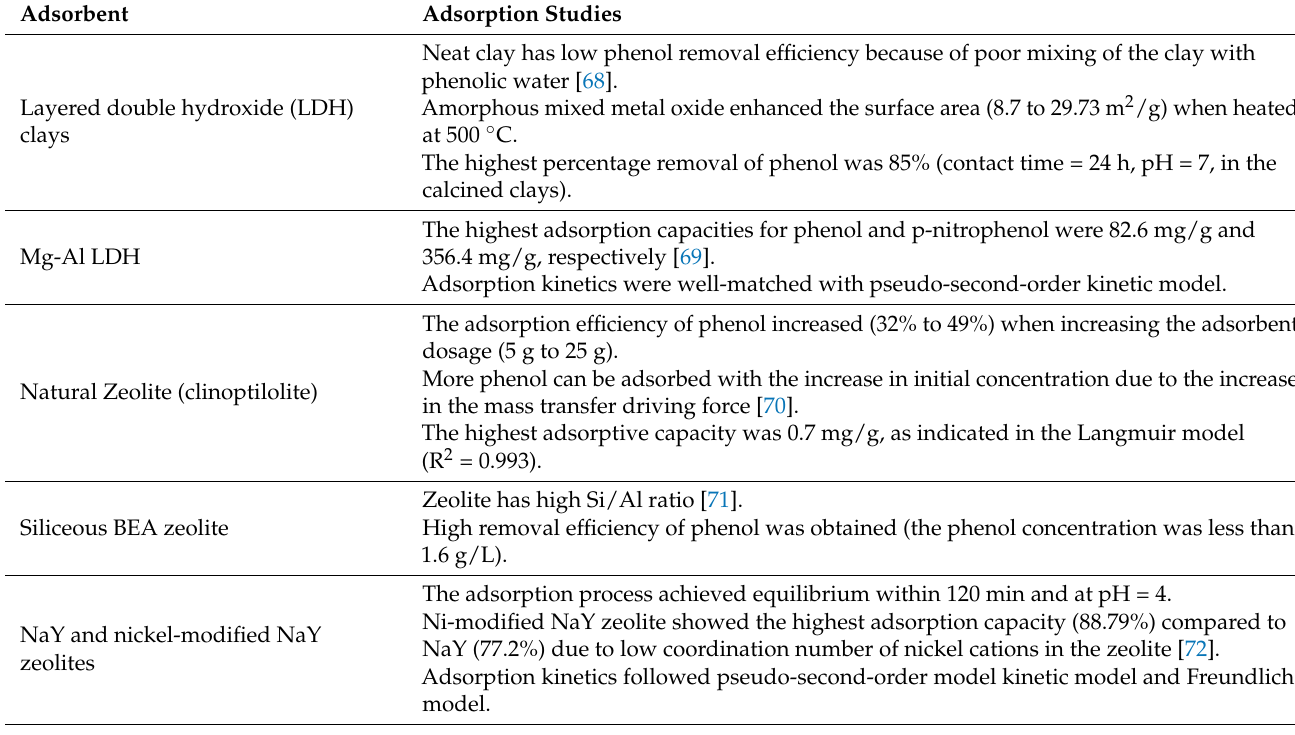
Table 5. Kinetics, isotherms, and thermodynamic studies of the adsorption of phenol and phenolic compounds from wastewater using different